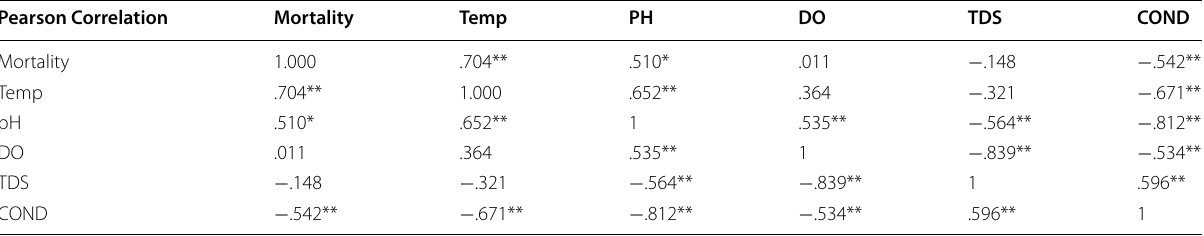
Table 5 Correlations of mean mortality values and mean values of physicochemical parameters of ethanolic leaf extract of Cymbopogon